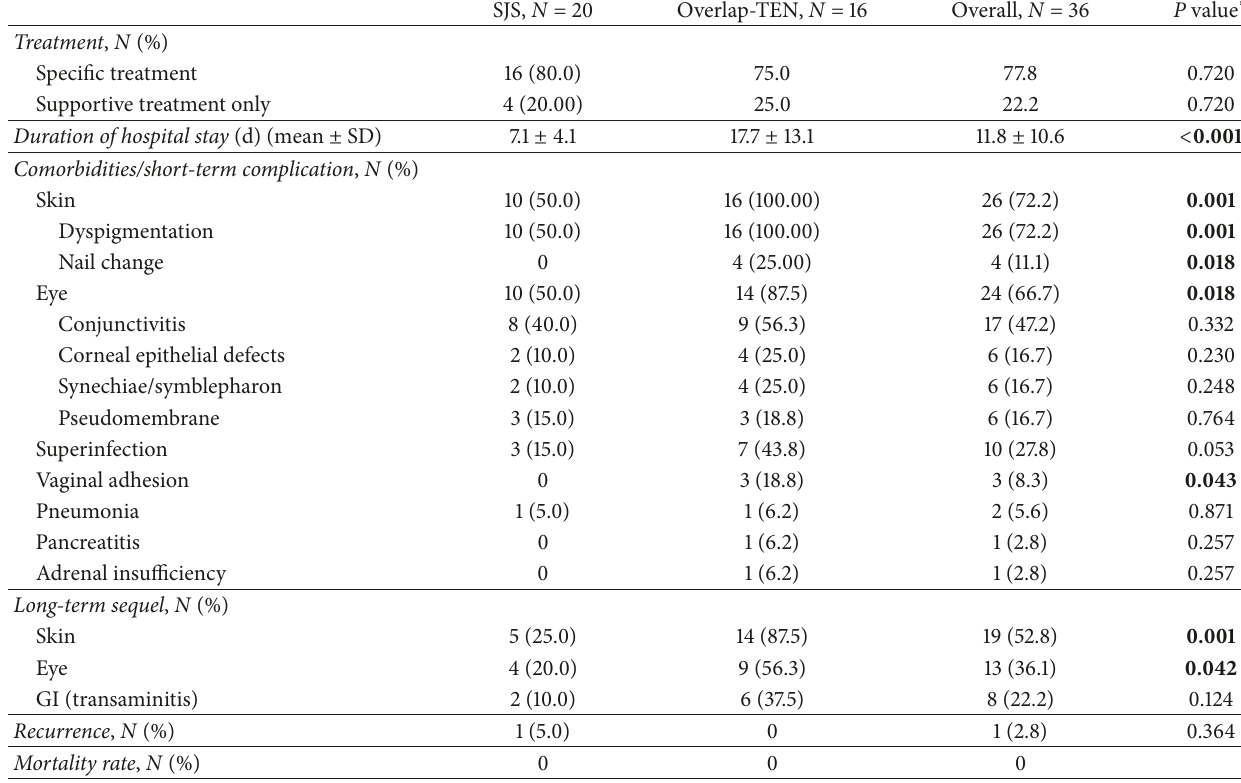
Table 3: Treatment and treatment outcomes of patients with Stevens-Johnson syndrome and overlap-toxic epidermal